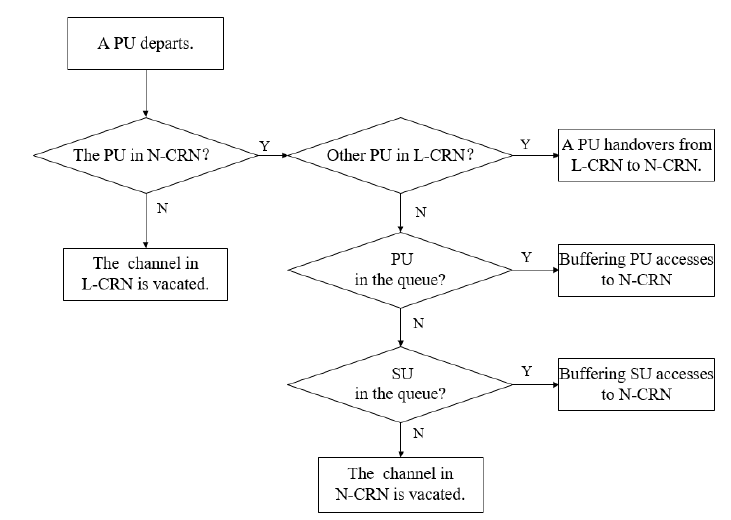
Figure 5. The procedure when a PU departs.